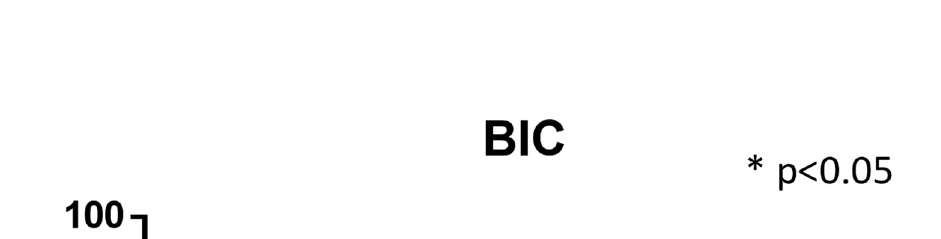
Fig 4. RT. The RT values of the PTHa group were significantly higher than those of the PTHb and Control groups. There was no significant difference between the PTHb and Control groups.